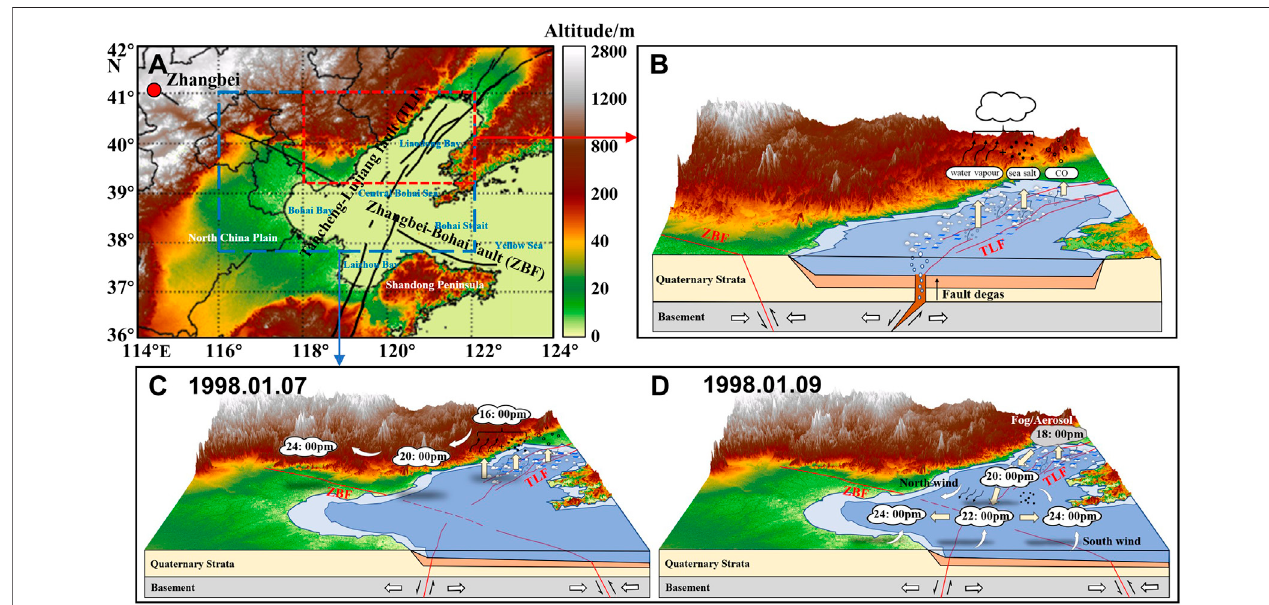
FIGURE14|(A) TheDEMinthestudyareaand thespatialrange of (B – D) . (B) Conceptual diagramoftheLCAcouplingand manifestationprocess ofatmospheric disturbances (C,D) . The particular spatial distribution and strip-shaped low-level clouds occurred on January 7 and 9